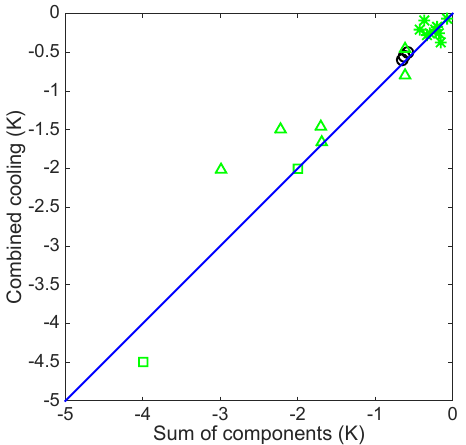
Figure 6. Comparison between combined cooling benefit (com- bined simulation results) and sum of the components (sum of in- dividual simulation results). Both are measured by screen-height air temperature. Black symbols: cool roof + solar panel roof; green symbols: cool roof + green roof; circles: Salamanca et al. (2016); squares: Taha et al. (1997); stars: Stone et al. (2014); triangles: Georgescu et al.